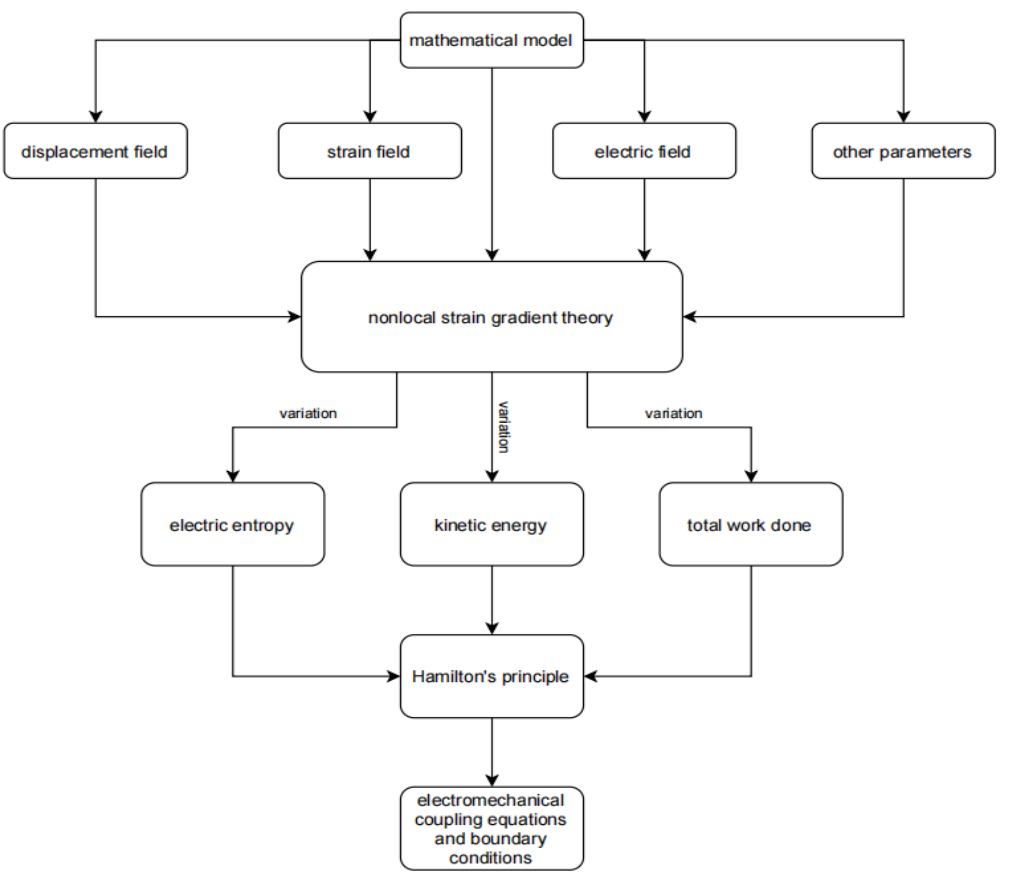
Figure 3. Mathematical modeling process diagram.